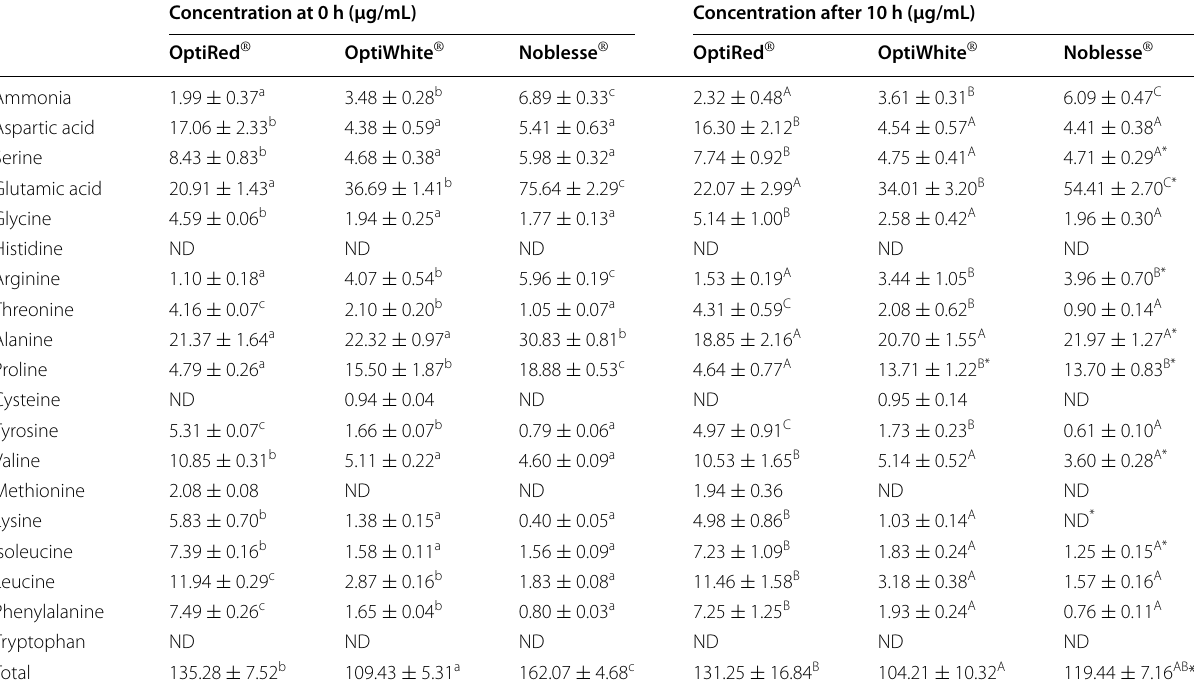
3). Mean values in the same row with different lower and upper case =